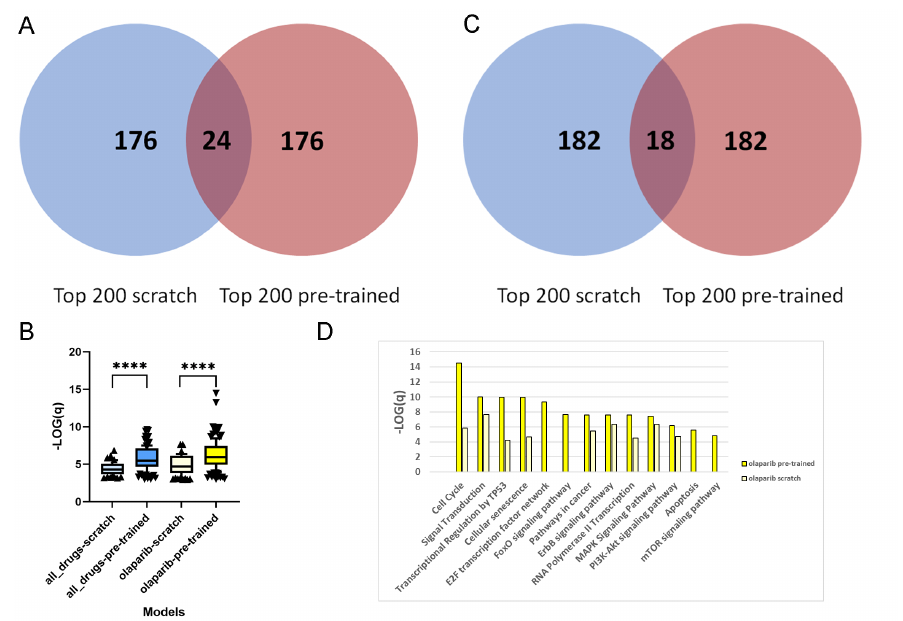
Figure 2. Feature importance analysis. ( A ) Venn diagram of top 200 features for the model trained from scratch (blue) and the pre-trained (red) PaccMann model on the PDO data set. Feature impor- tance values were averaged over all drug–PDO pairs. ( B ) Box-plots of pathway enrichment scores of the top-ranked 200 genes derived from feature importance values of the pre-trained model and the model trained from scratch for all drugs and specifically for the drug olaparib (x-axis). The y-axis denotes the − log of the adjusted enrichment p -values. Boxes denote the 10–90% ranges of 10 pathway enrichment scores. Pathway gene sets were taken from the ConsensusPathDB resource and were judged as significantly enriched if Fisher’s exact test resulted in a p -value of below 0.001, and if the pathway shared at least 10 genes with the 200 top-ranked genes. Sizes of samples were: all-drugs-scratch: 62 pathways; all-drugs-pre-trained: 120; olaparib-scratch: 84; olaparib-pre-trained: 126. On top of each model pair, the result of an unpaired, two-sided Mann–Whitney test is displayed (****: p < 0.0001). ( C ) Venn diagram of top 200 features from the scratch (blue) and pre-trained (red) PaccMann models and the PDO data set. Feature importances were averaged over the olaparib–PDO pairs. ( D ) Bar plot of selected enrichment pathway scores ( − log of adjusted enrichment p -value, 10 y-axis) for the 200 top-ranked genes from the scratch (light yellow) and pre-trained (strong yellow) PaccMann models using the feature importance values for all olaparib–PDO pairs; x-axis: pathways related to DNA damage repair and